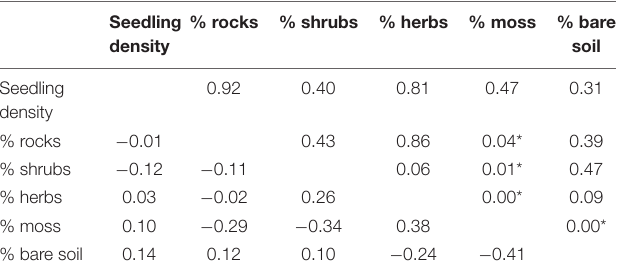
TABLE 2 | Correlations between components of ground cover and seedling density.